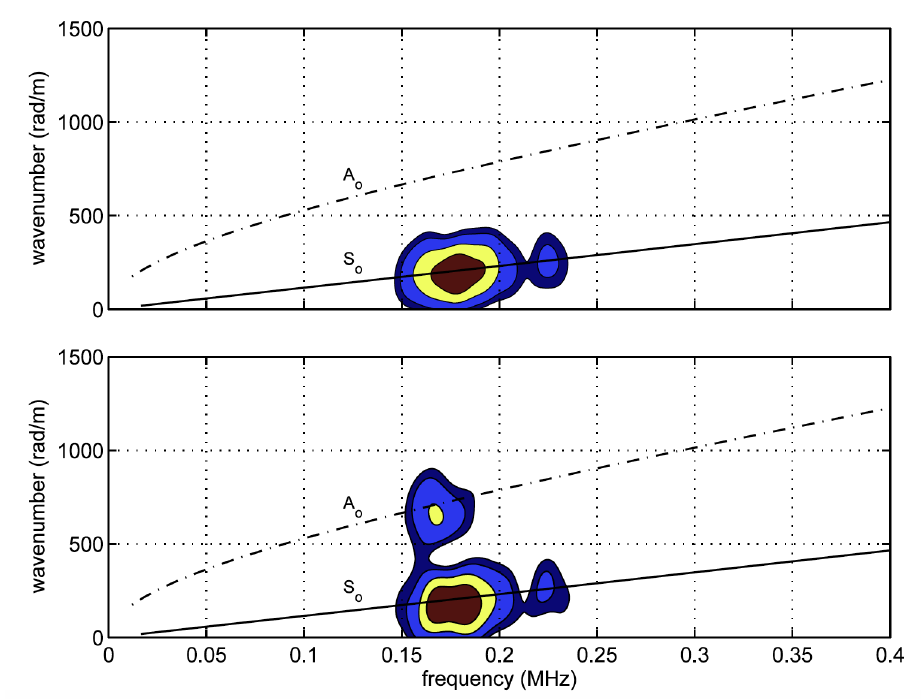
Figure 21. Spectral decomposition of a FBG sensor array response measured for a selectively excited S 0 mode in the absence of the bonded disc ( top ) and after attachment of the disc ( bottom ) [118]. The- oretical dispersion curves are also shown. Reprinted with permission from [118] ©IOP